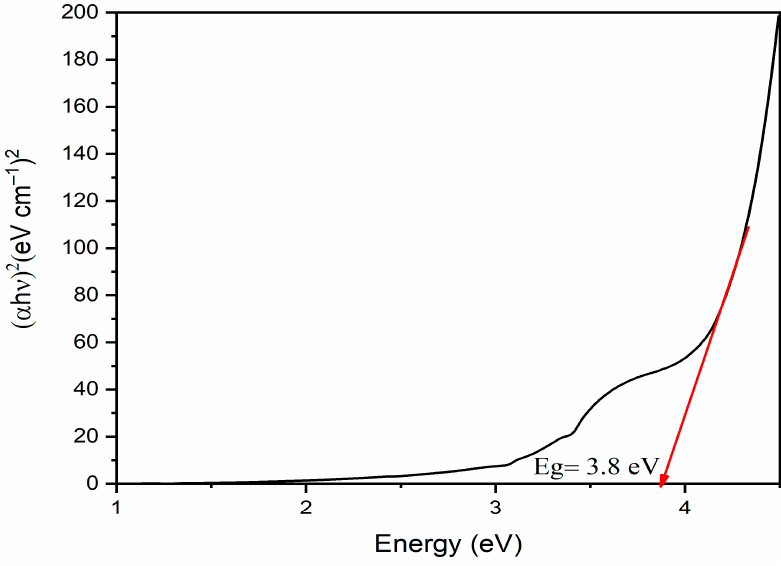
Figure 4. Band gap energy of the bio-produced